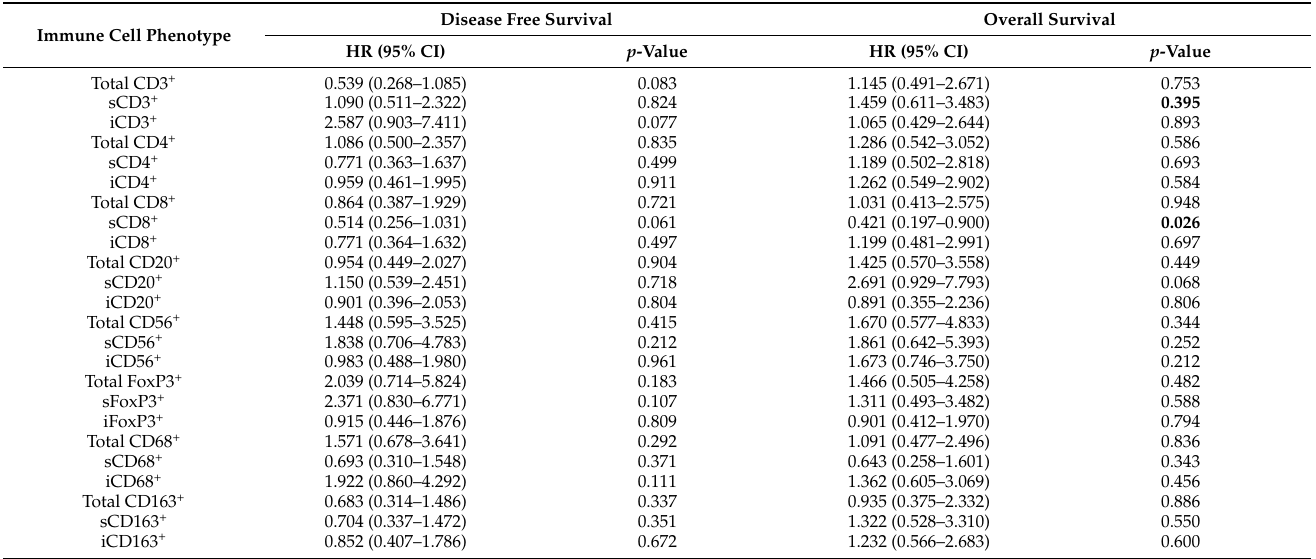
Table 3. Univariate Cox regression analysis of disease-free survival and overall survival according to immune cell phenotype.